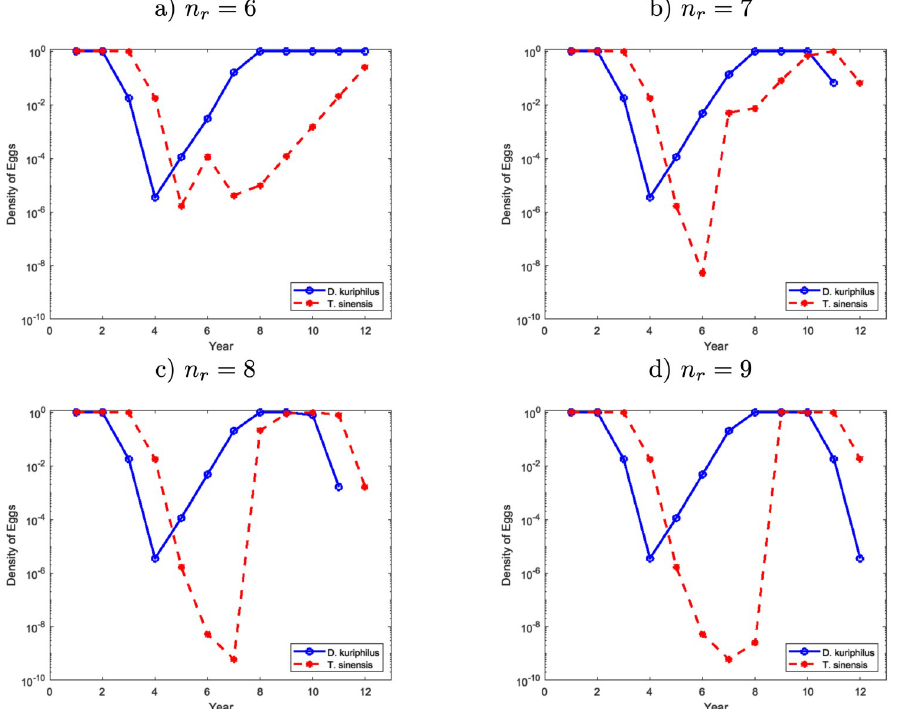
) and T . sinensis ( q ) in a given place of the forest over the time after several n n